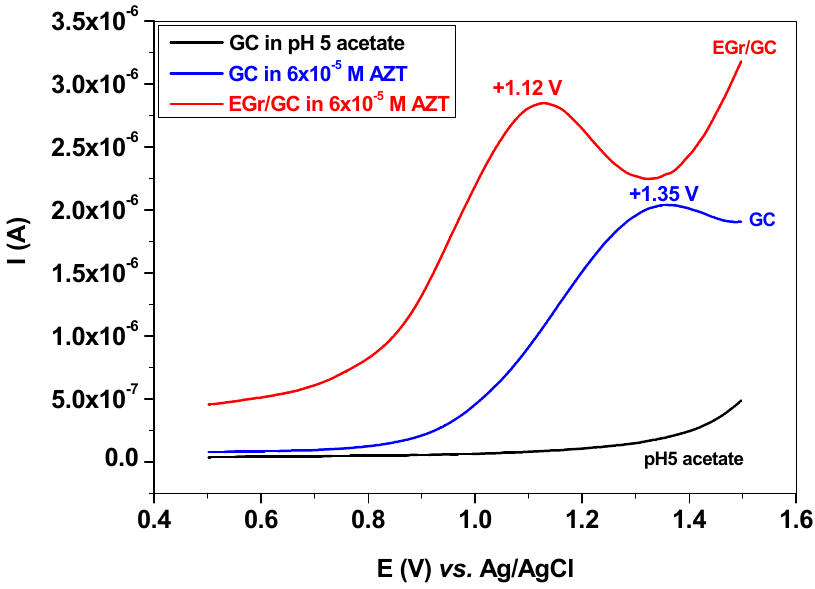
Figure 7. DPV signals recorded in pH 5 acetate containing 6 × 10 − 5 M AZT: EGr/GC (red curve) and GC (blue); GC in pH 5 acetate (black curve).